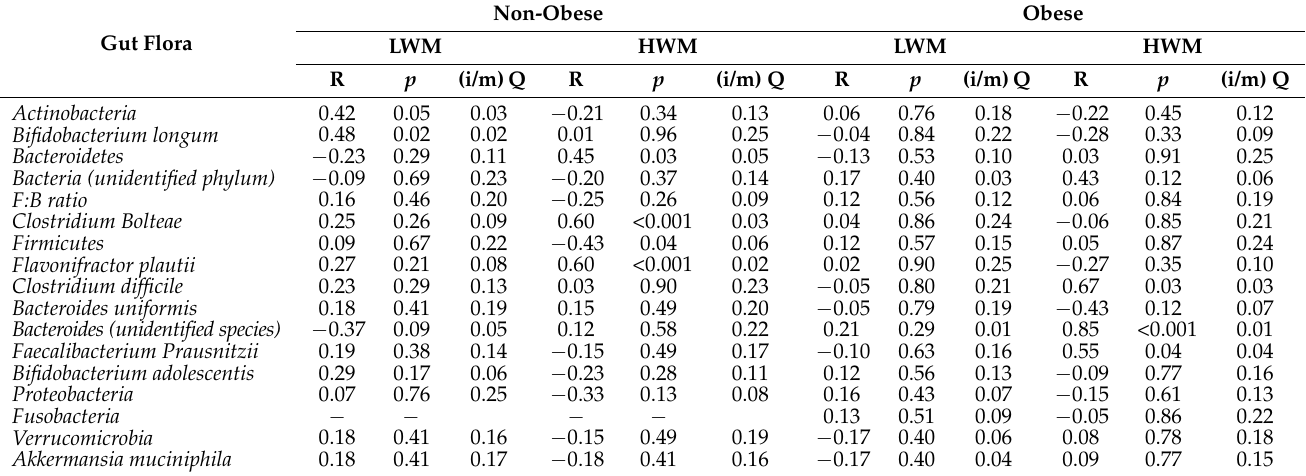
1 Data are presented as Pearson correlation coefficients adjusted for age. F:B: Firmicutes to Bacteroidetes; HWM: high white meat intake; LWM: low white meat intake; (i/m) Q: Benjamini-Hochberg critical value for a false discovery rate of 0.25. High white meat intake is >25 g/1000 kcal for the obese group, low white meat intake is ≤ 25 g/1000 kcal for the obese group, high white meat intake is >34 g/1000 kcal for the non-obese group, and low white meat intake is ≤ 34 g/1000 kcal for the non-obese group. The hyphens in cells indicate that gut flora is not present in these categories or that the number of observations for this group is not high enough to report